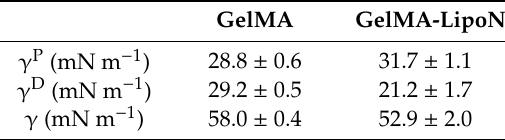
Table 2. The surface tension of hydrogels ( γ ) and its polar ( γ P) and dispersive ( γ D)